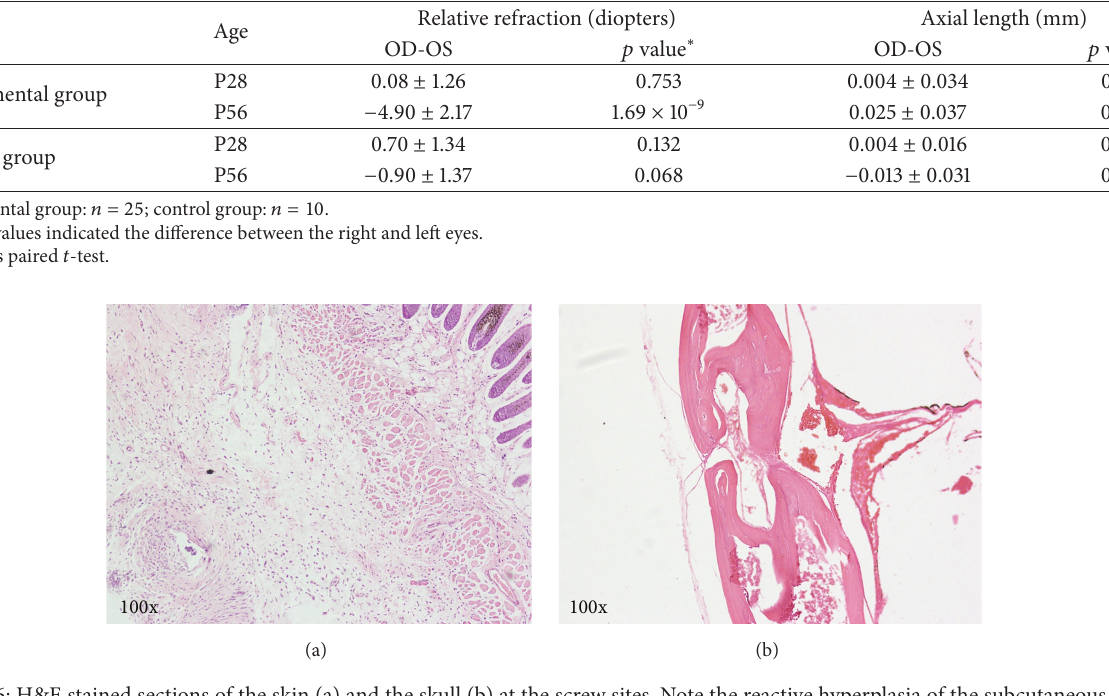
Figure 6: H&E stained sections of the skin (a) and the skull (b) at the screw sites. Note the reactive hyperplasia of the subcutaneous tissue, and the absence of a glaucomatous reaction or destructive changes to the